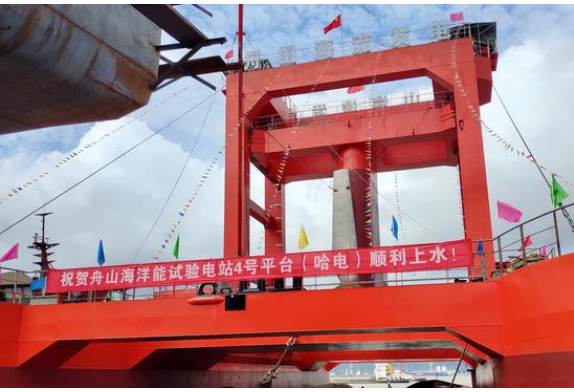
Figure 32. Ocean energy test platform for 600 kW Submarine TCPGS. Reproduced from [84].